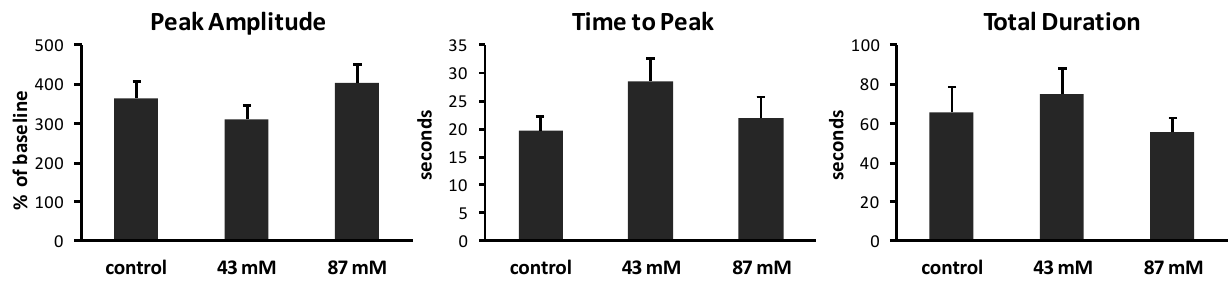
Figure 4. Characteristics of Ca 2+ waves in axonal growth cones. Calcium imaging at 1 image/s generated plots of fluorescence over time. Analysis was performed on axonal growth cones that displayed at least one Ca 2+ wave during 10 min ( n = 14–15 growth cones per treatment group). Peak amplitudes of waves are expressed as the mean percent of baseline fluorescence (±SEM). Time to peak and total duration of waves are expressed as the mean time in seconds (s) (±SEM) to reach maximum fluorescence and to rise to the peak and return to baseline, respectively.